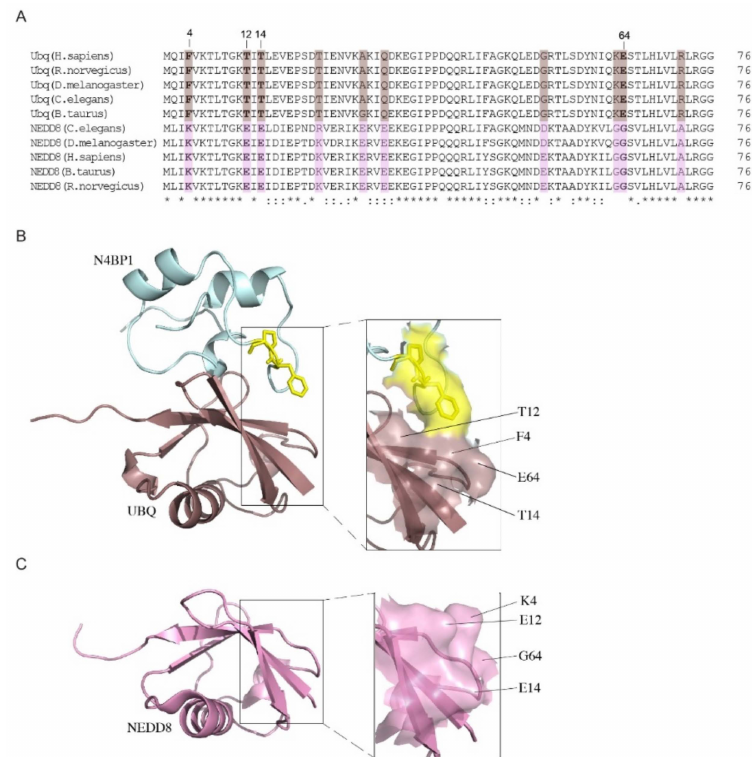
Figure 10. ( A ) Amino acid sequence alignment of ubiquitin and NEDD8 orthologs performed with Clustal Omega (https: // www.ebi.ac.uk / Tools / msa / clustalo). Consensus symbols used in the alignment: ‘.’ indicates conservation between groups of weakly similar properties; ‘:’ indicates conservation between groups of strongly similar properties; ‘*’ indicates fully conserved residue. Conserved / divergent positions are highlighted in colored boxes (brown for ubiquitin, violet for NEDD8). ( B ) Complex between the UBD of N4BP1 and ubiquitin. The conserved / divergent patch in ubiquitin (brown) is represented by F4, T12, T14, and E64 (shown in bold in the sequence alignment). ( C ) The corresponding pattern in NEDD8 (violet) includes residues K4, E12, E14, and G64. The magnification of both patterns is shown. Protein models were obtained with PyMol using the HADDOCK model